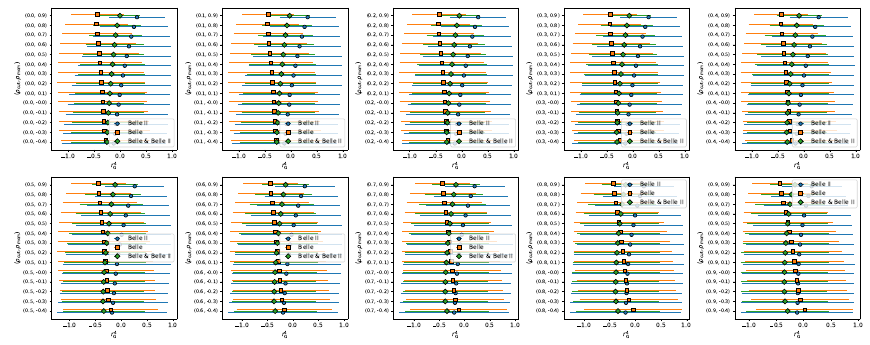
for different combinations of correlation parameter values. Figure 14 . Fit results for r 4 G